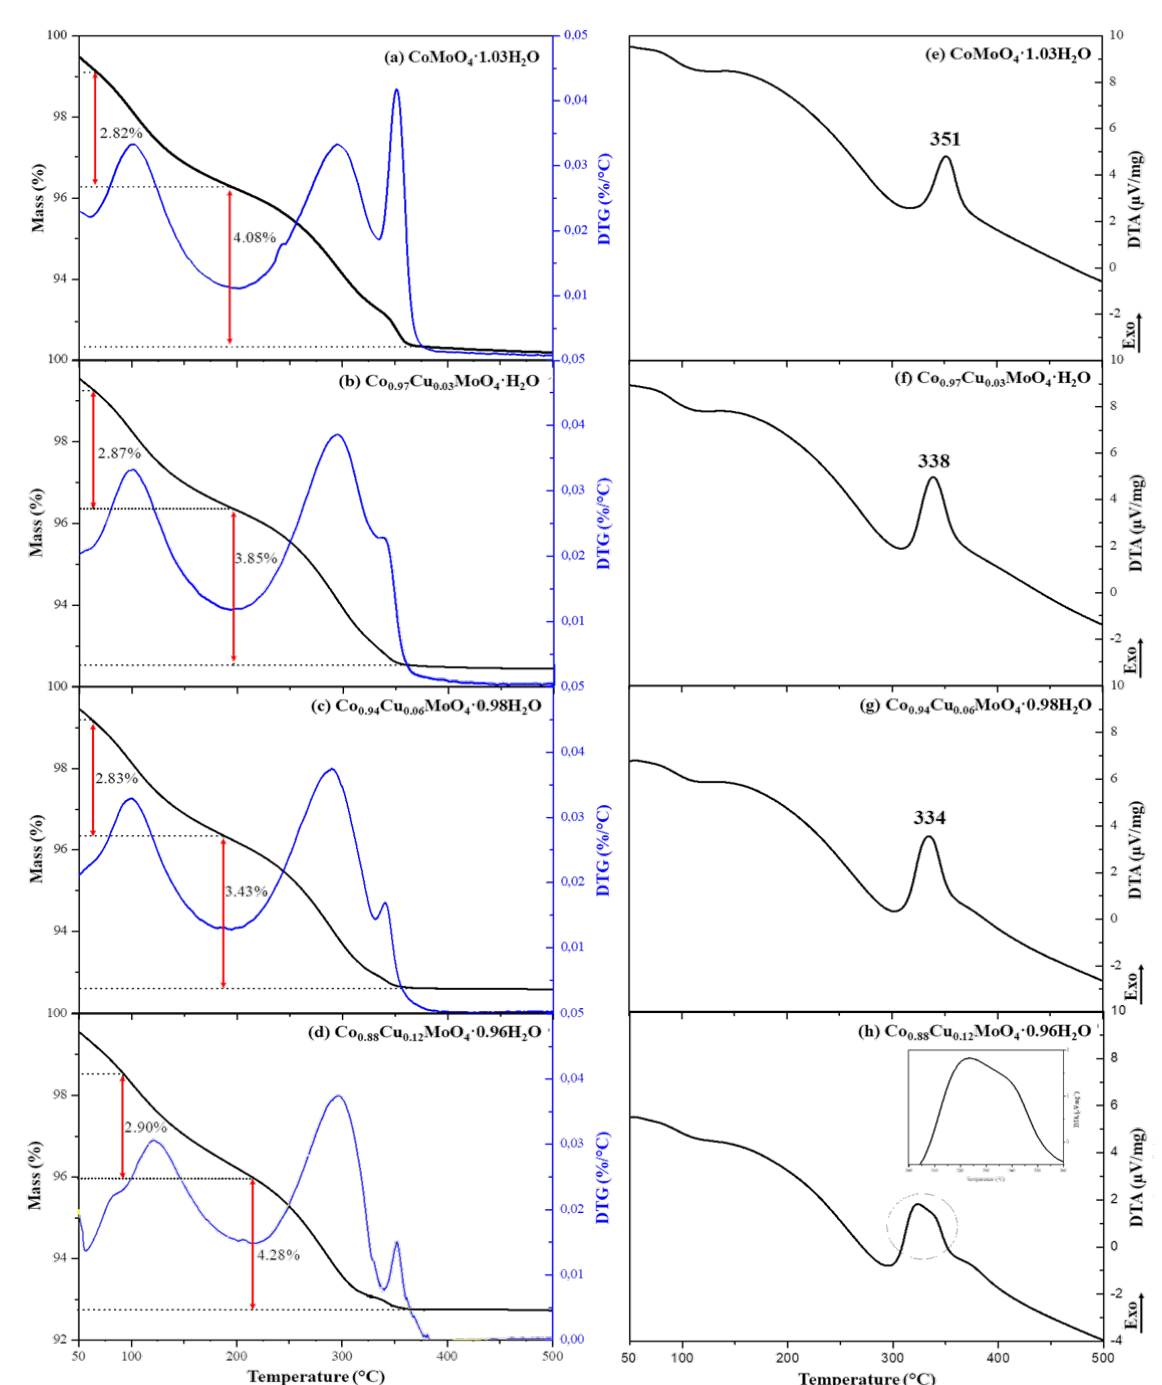
Figure 3. Themogravimety/thermogravimetric derivative (TG/DTG) and Differential thermal analysis (DTA) curves for ( a , e ) pure CoMoO 4 · nH 2 O and Co 1 − x Cu x MoO 4 · nH 2 O with x equals to ( b , f ) 0.03, ( c , g ) 0.06, and ( d , h ) 0.12.